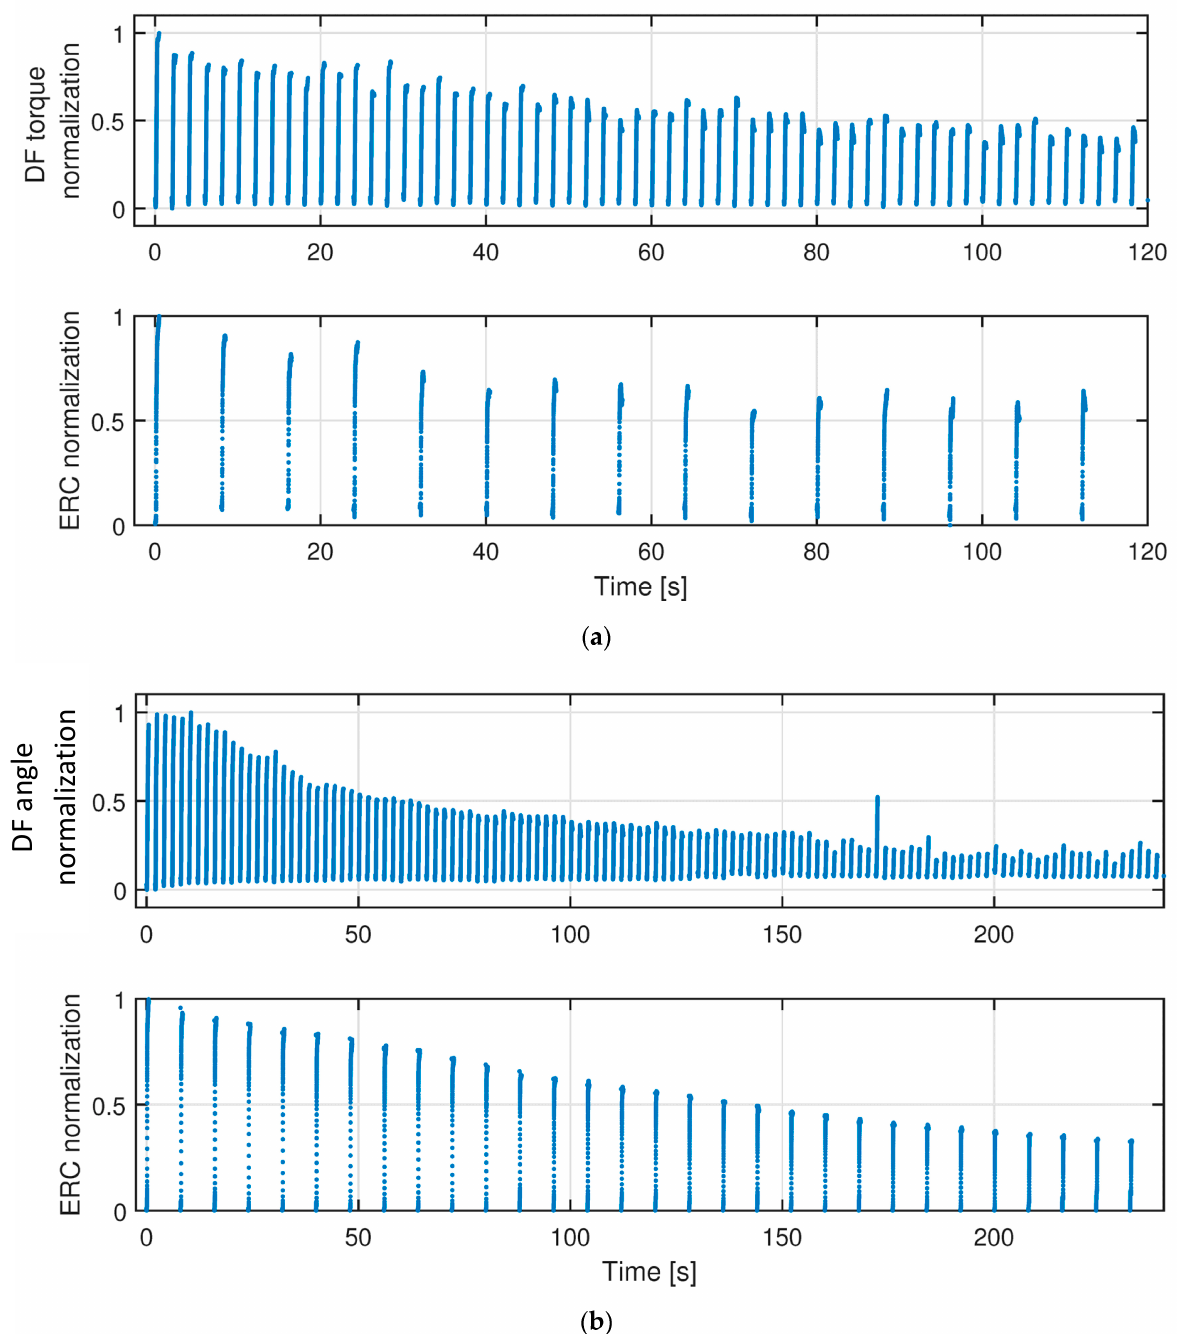
Figure 5. The representative effects of FES-induced TA muscle fatigue on each recorded stimulation cycle of the isometric dorsiflexion torque normalization, dynamic dorsiflexion angle normalization, and US ERC normalization on Participant Sub03. ( a ) Normalization of dorsiflexion torque and ERC in each recorded stimulation cycle due to TA muscle fatigue under the isometric condition. ( b ) Normalization of dorsiflexion angle and ERC in each recorded stimulation cycle due to TA muscle fatigue under the dynamic